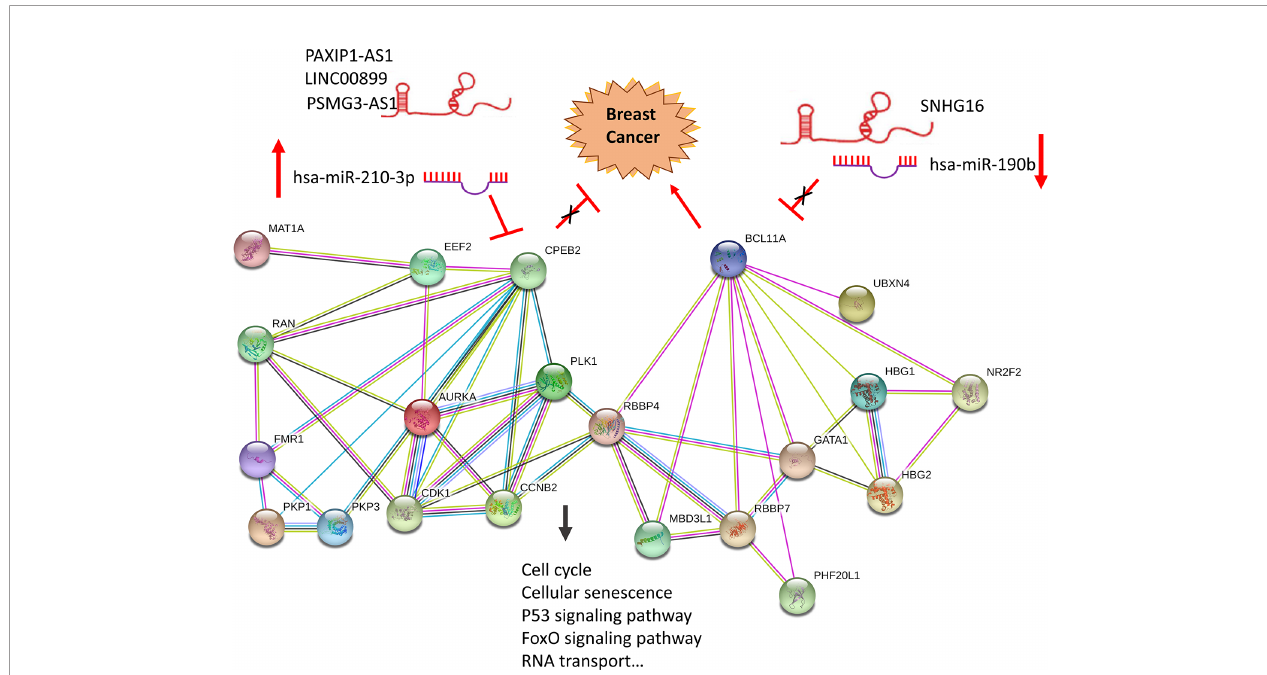
FIGURE 8 | Construction of a hypoxia related ceRNA regulation network based on differentially expressed miRNAs and DEGs. Loss of LINC00899, PSMG3-AS1 and PAXIP1-AS1 leads to increased hsa-miR-210-3p. When overexpressed, hsa-miR-210-3p impedes translation of CPEB2, a tumor suppressor gene in breast cancer under hypoxia status. High expressed SNHG16 can suppress hsa-miR-190b, which leads to increased expression of BCL11A, an oncogene in breast cancer.